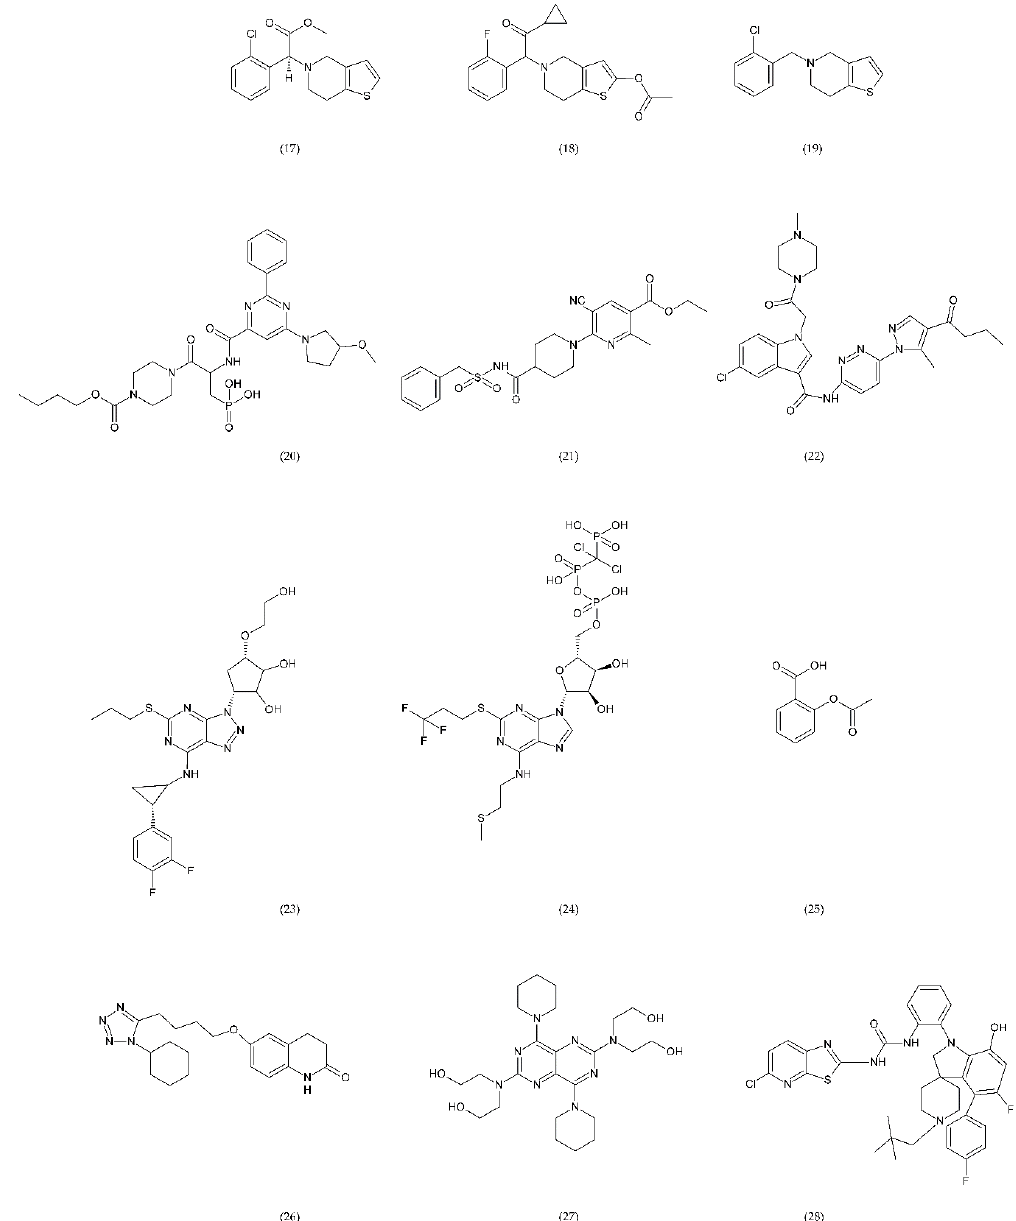
Figure 10. Antiplatelet drugs: clopidogrel (17), prasugrel (18), ticlopidine (19) as well as novel compounds ACT246475 (selatogrel) (20), AZD1283 (21), and SAR216471 (22) are active antiplatelet drugs irreversible, competitive, thienopyridine P2Y12 receptor antagonists, while ticagrelor (23) and cangrelor (24) are reversible P2Y12 receptor antagonists. ASA (25) inactivates cyclooxygenase (COX) by irreversible acetylation in the metabolism of arachidonic acid (AA). Cilostazol (26) inhibits the platelet aggregation induced by collagen, ADP, epinephrine, and AA. Dipyridamole (27) the potential of endogenous anticoagulants and the patency of small vessels and capillaries. BMS-884775 (28) and P2Y1 antagonist demonstrated similar anticoagulant properties such as prasugrel. Glycoprotein IIb/IIIa has an important role in the adhesion and aggregation of platelets and occurs quite abundantly on the surface of platelets being fibrinogen binding site. Eptifibatide (Figure 11) is a cyclic natural heptapeptide that inhibits platelet aggregation found in the venom of the